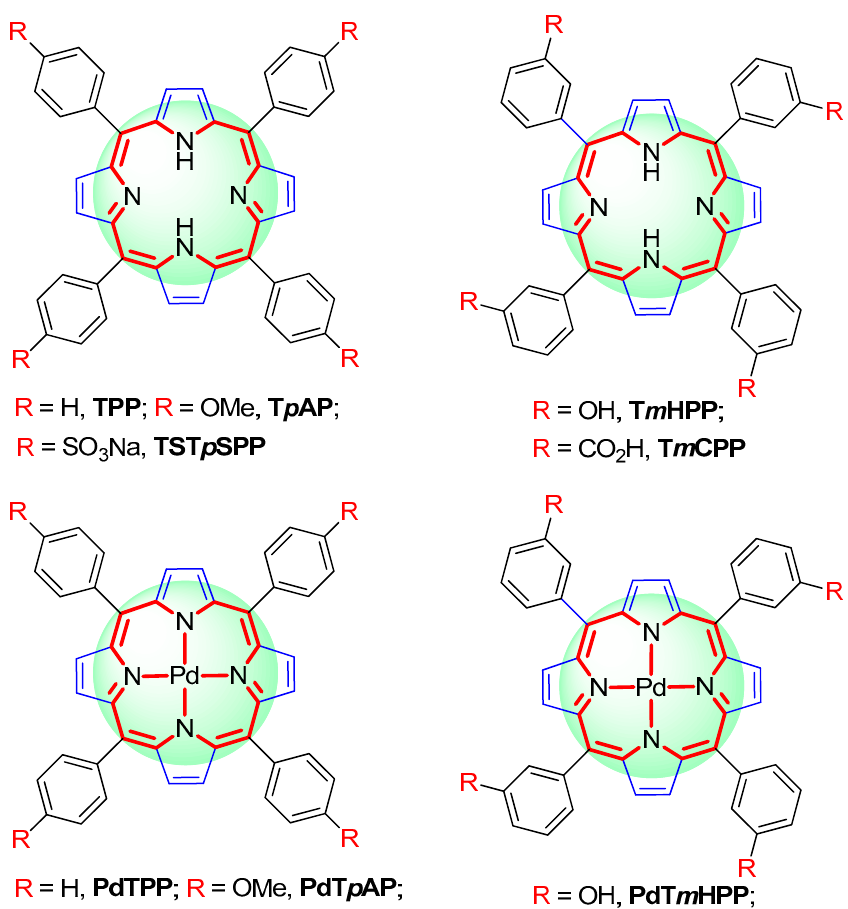
Figure 2. Chemical structures of porphyrins and their N -pincer Pd(II)-complexes (catalysts). Initially, potassium 4-methoxyphenyltrifluoroborate ( 1a ) was found to participate in self-coupling to give 98% of biaryl, 2a (in 15 min) using 0.1 mol% of PdTST p SPP , 4 mL of